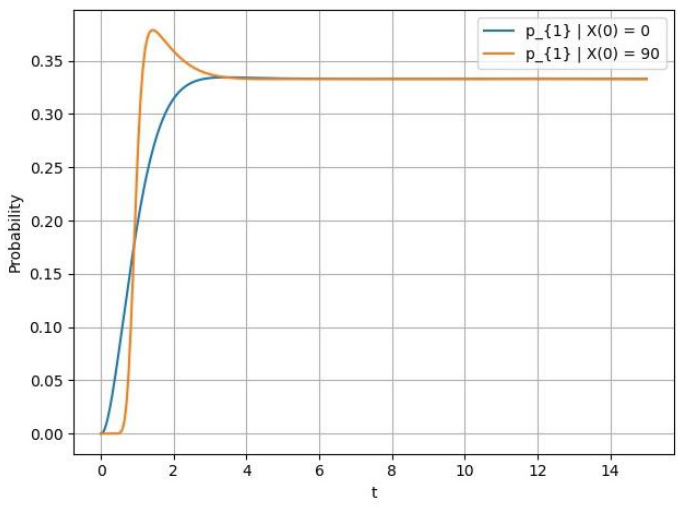
Figure 4. Probability p 1 ( t ) for t ∈ [ 0,14 ] ; this figure shows the rate of convergence.